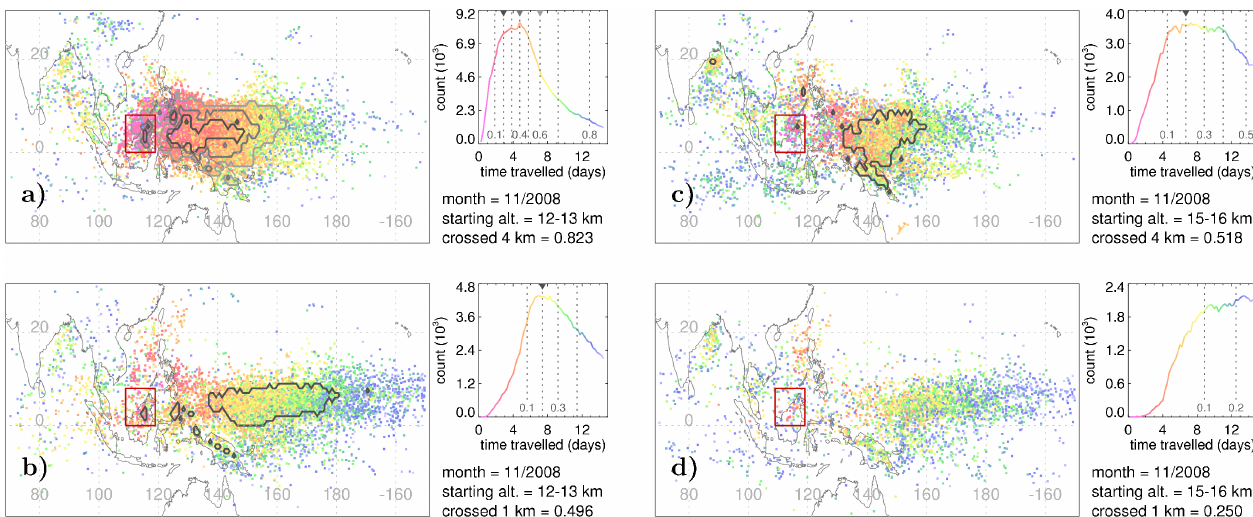
Fig. 1. The maps show trajectory crossing locations. Back trajectories start at random within the red rectangle throughout November 2008. In (a) and (b) trajectories start between 12–13km, in (c) and (d) trajectories start between 15–16km. The coloured dots in (a) and (c) show where a random sample of 5% of trajectories first crossed 4km above the surface, while (b) and (d) show the same for 1km. The dots are coloured by the time taken to cross either 1 or 4km. To the right of each map are probability distributions of crossing times (6h bins), where the colour of the line relates to the colours of the dots in the map. Successive deciles are marked with dashed grey lines, and the total fraction of trajectories that cross within 15 days is noted below. Where there are sufficient trajectories, the grey down-turned triangles mark the fraction crossing within the contour of the same colour on the